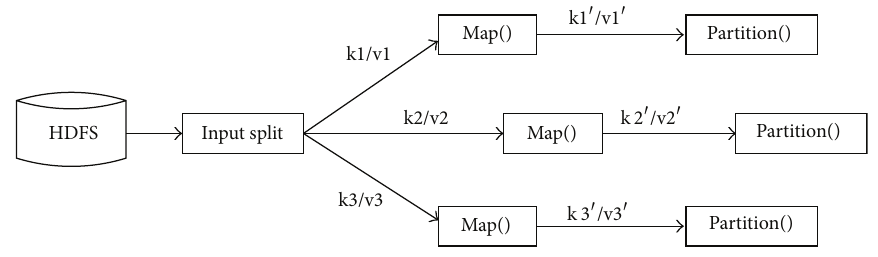
Figure 2: The execution figure of Map.